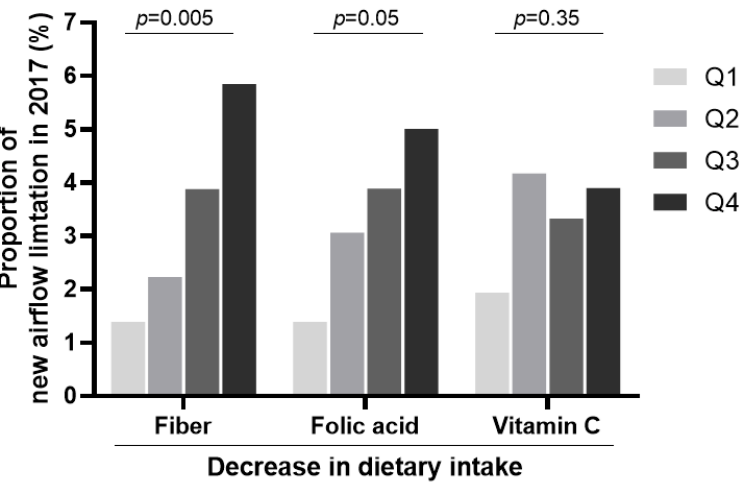
Figure 3. The proportion of subjects showing a new airflow limitation at the 5-year follow up in different nutrient intake quartiles. The development of new airflow limitation was highest in the quartile showing the highest decrease in fiber, folic acid, and vitamin C intake. The differences were significant for fiber and folic acid. The decreased intakes of each nutrient in the quartiles were as follows: fiber Q1, − 5.515~0.999: fiber Q2, 1.000~2.049: fiber Q3, 2.050~3.190: fiber Q4,